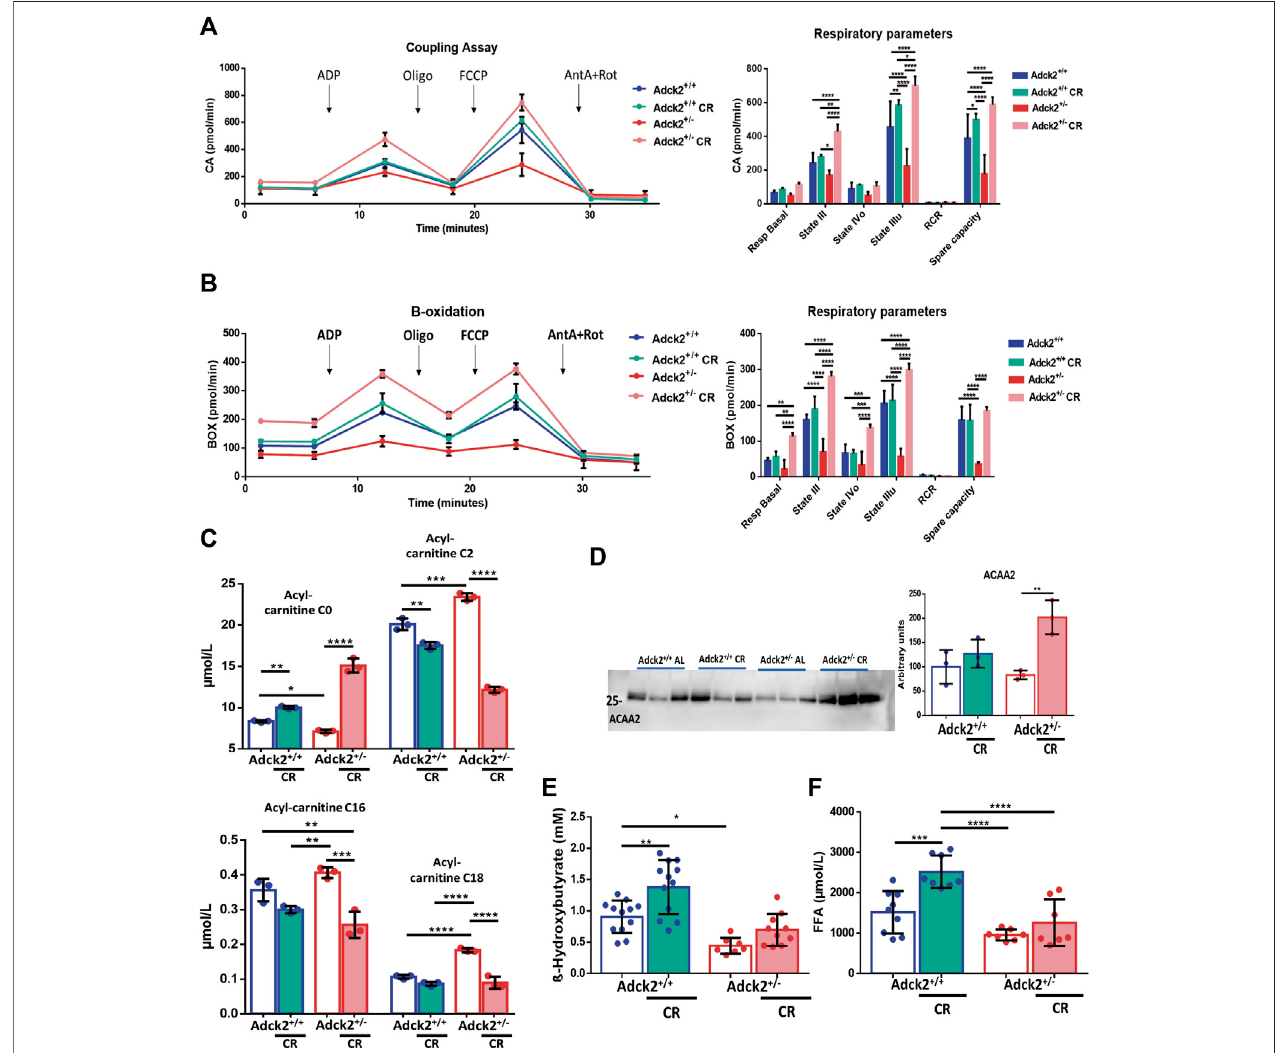
FIGURE 5 | Bioenergetics approach to calorie restriction and mitochondria metabolism. (A) . Coupling Assay and (B) Fatty acids β -oxidation on mitochondria isolatedfromskeletalmuscleoncalorierestriction.Foreachexperiment10 µgofmitochondrialsuspensionwasseededperwell.Onerepresentativeexperimentofthree independentexperimentsinshown.RCRforCouplingassay: Adck2 +/+ 5.30±1.39, Adck2 +/+ CR5.28±0.13, Adck2 +/ − 5.30±1.59, Adck2 +/ − CR6.93±1.28.RCRfor β -oxidation assay: Adck2 +/+ 2.39 ± 0.08, Adck2 +/+ CR 3.24 ± 0.26, Adck2 +/ − 1.35 ± 0.34, Adck2 +/ − CR 2.19 ± 0.06. (C) . Acyl-carnitine (C0), (C2), (C16), (C18) measurements inplasma. Datarepresentthe mean ± SD (N= 3). (D) Acetyl-CoA Acyltransferase 2(ACAA2) protein levels in skeletal muscle. Datarepresentthe mean ± SD (N=3). (E) . β -Hydroxybutyrate plasmalevels. Datarepresentthemean ±SD(Adck2 +/+ N=12,Adck2 +/ − N=9,Adck2 +/+ CRN=12, Adck2 +/ − CRN=11). (F) .Free fatty acid plasma levels. Data represent the mean ± SD (Adck2 +/+ N = 9, Adck2 +/ − N = 7, Adck2 +/+ CR N = 8, Adck2 +/ − CR N = 7). One-way and two-way ANOVA tests were applied. CR, calorie restriction. * p < 0.05; ** p < 0.01; *** p < 0.001; **** p < 0.0001.